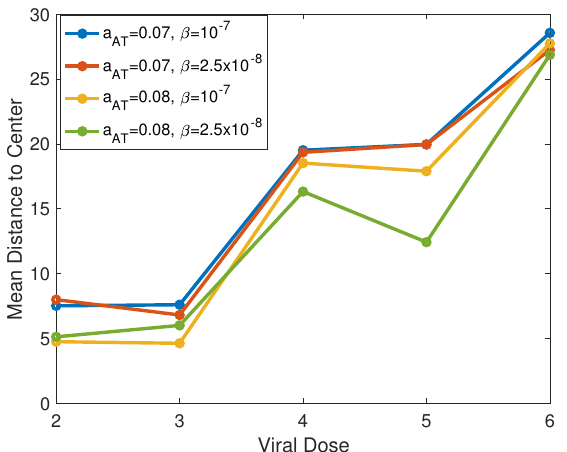
Figure 11. Mean adaptive viral dosing distance to the center of the domain. The means are shown from 40 realizations of each parameter set for adaptive viral doses